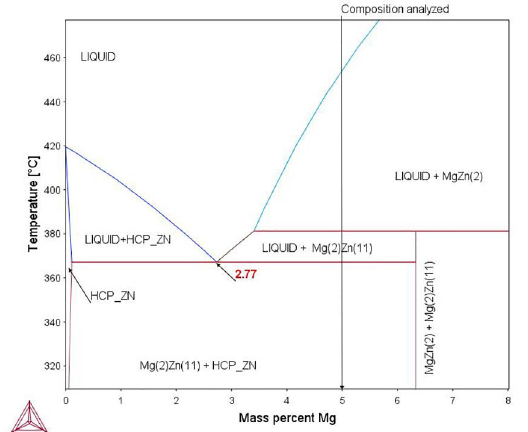
Figure 1. Zn-Mg partial phase diagram with indications of the analyzed alloy. Thermo-Calc PBIN